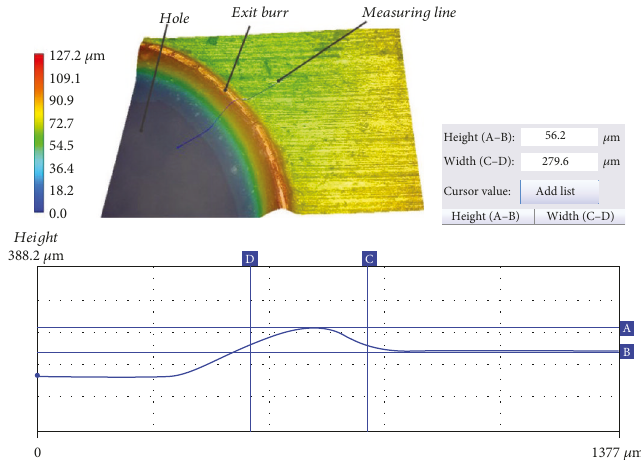
Figure 5: Measurement of the width and height of the burr at the hole exit.